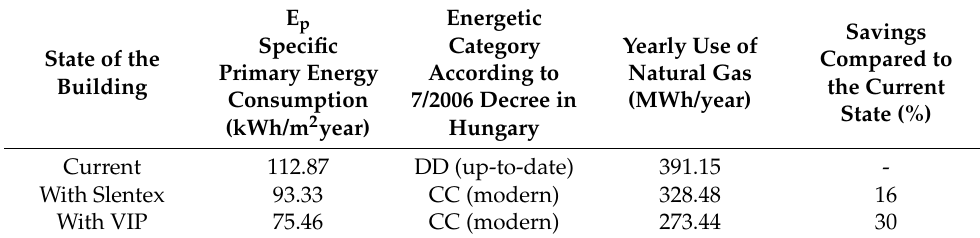
Table 5. Results of energetic